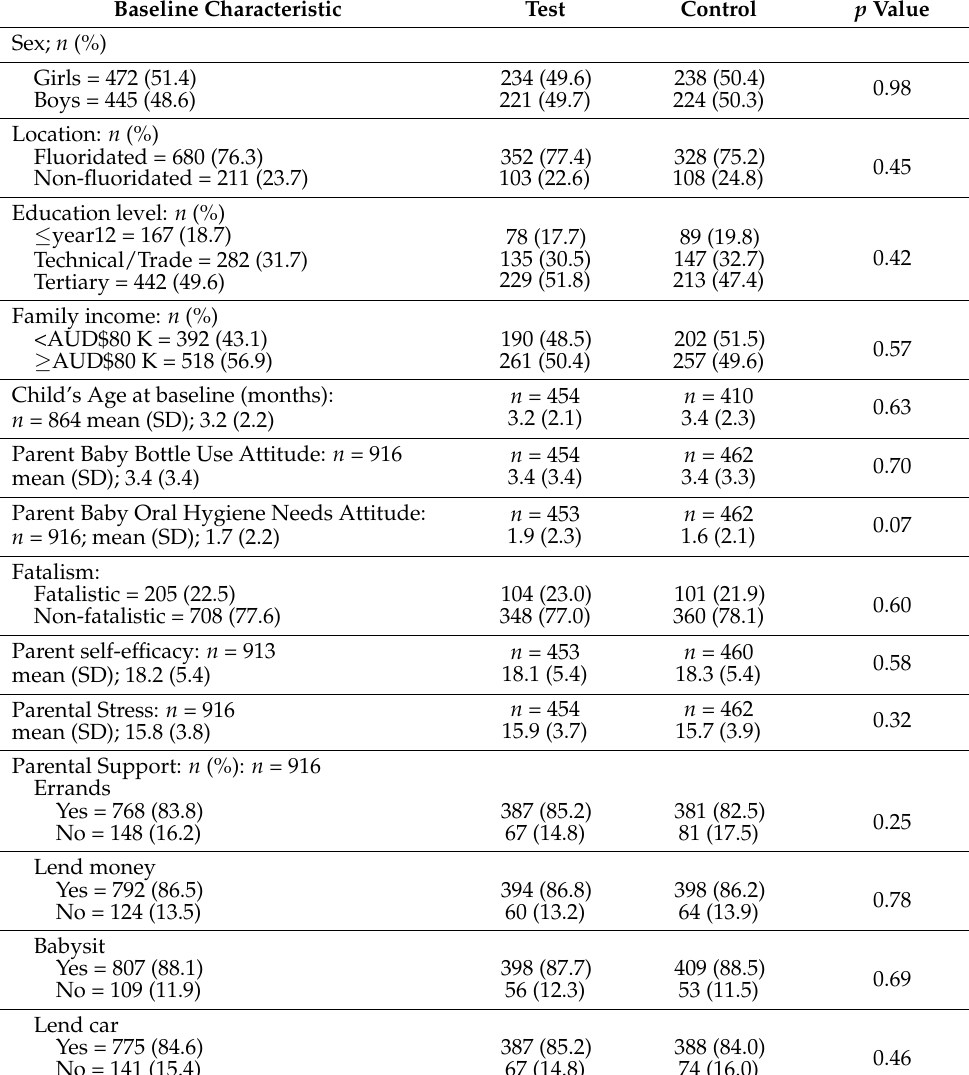
Table 1. Baseline characteristics of children in the test and control group at baseline. Baseline